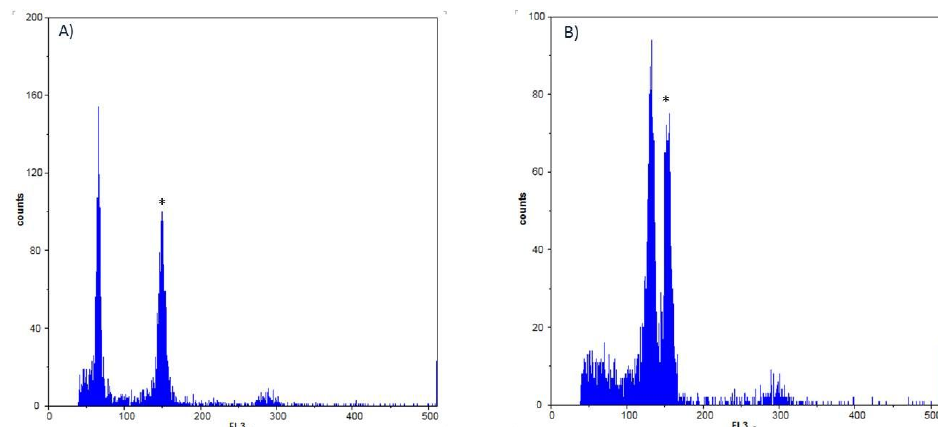
Spodoptera littoralis µg.larvae − 1 * means no nodal segments for this part of experiment.